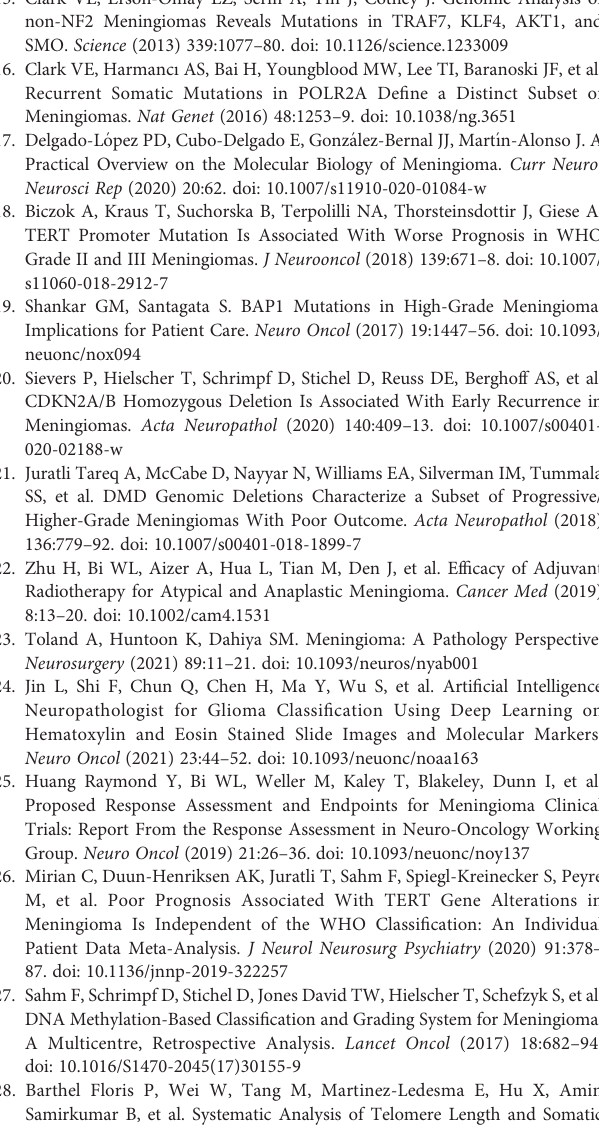
Supplementary Figure S1 | Pie chart fraction of TERT alterative subtypes occurring in TERT -alt HGMs. Supplementary Figure S2 | Heatmap of mutually exclusive or co-occurring set of genes in the mutation pattern of de novo HGMs following RT. Pairwise Fisher ’ s exact tests were performed to detect signi fi cant pairs of genes, mutually exclusive or co-occurring set of genes which colored by brown or green can be detected using the somaticInteractions function in R/Bioconductor package ‘ maftools ’ . Supplementary Figure S3 | The TERT -alt status and progressive variables did not show any relevancy in progression